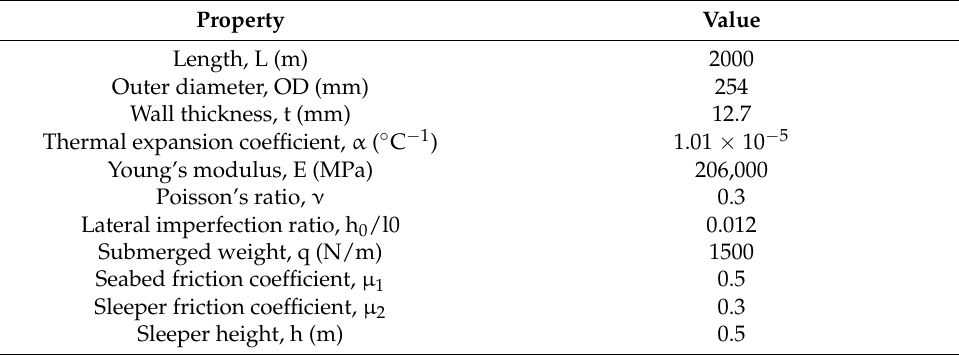
Figure 1. Pipeline and sleeper model used in the thermal buckling and seismic/thermal interaction analyses. Table 1. Pipeline and seabed properties.